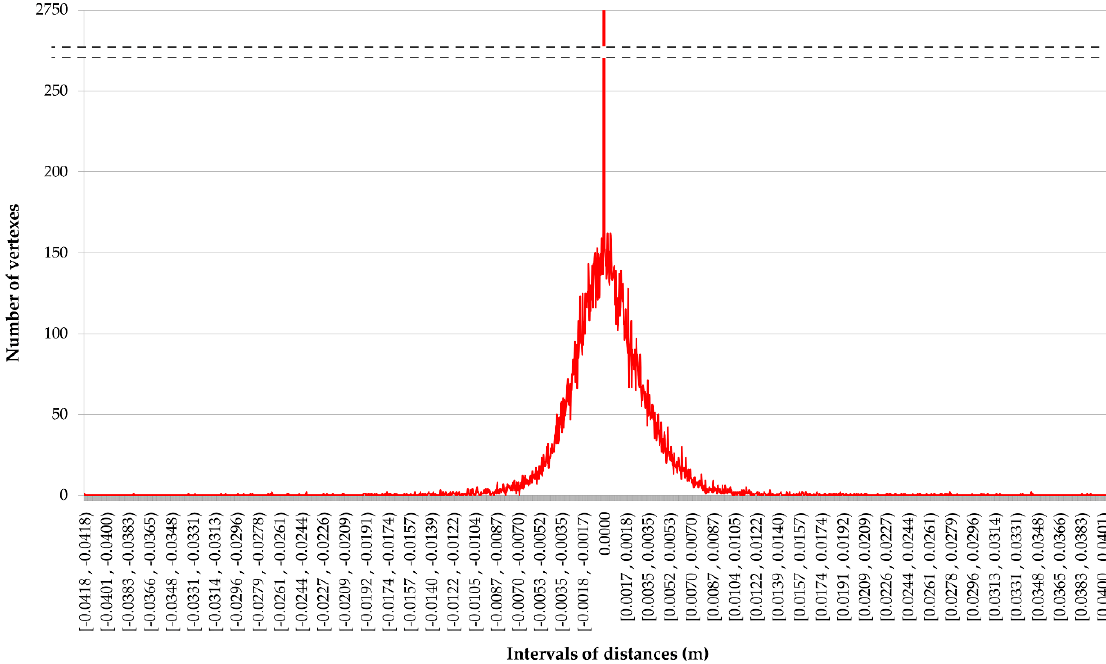
Figure 18. Cloud-to-mesh point deviation in a wall sector.